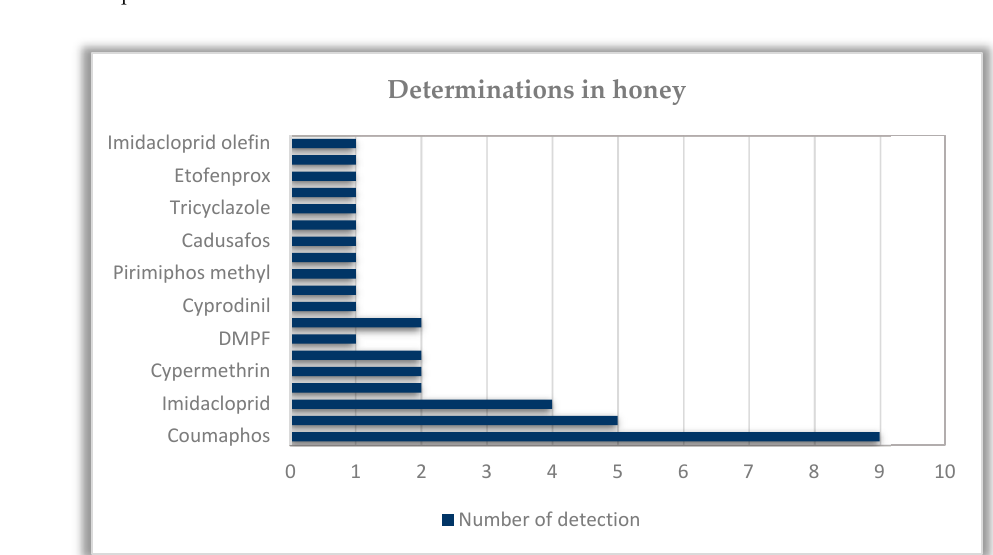
Figure 2. Graph showing determinations of active substances in honey (imidacloprid olefin is a metabolite of